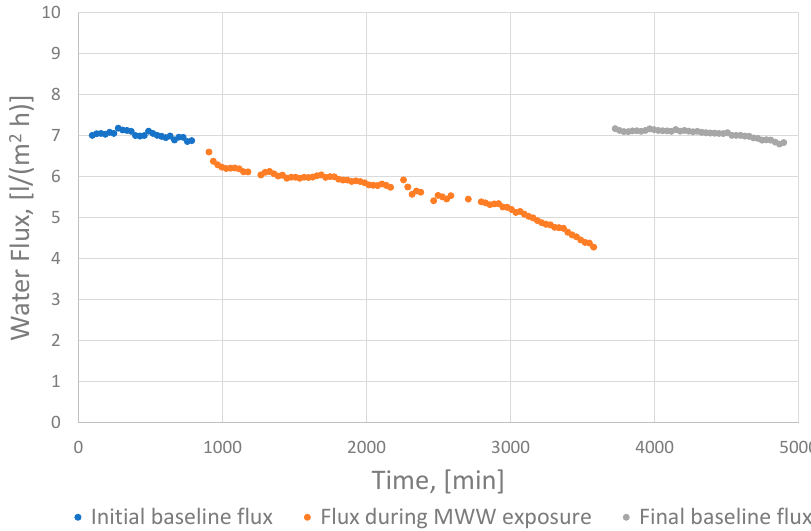
Figure 3. Observed water flux plotted as function of time for one of the experiments (HL–6**). At least part of the observed flux decline relates to the gradual decrease in the salt gradient across the FO membrane as the batch experiments elapsed. The decrease was ascribed both to reverse salt transport across the FO membrane and to the concentration of salt resulting from volume changes in the feed solution during the batch